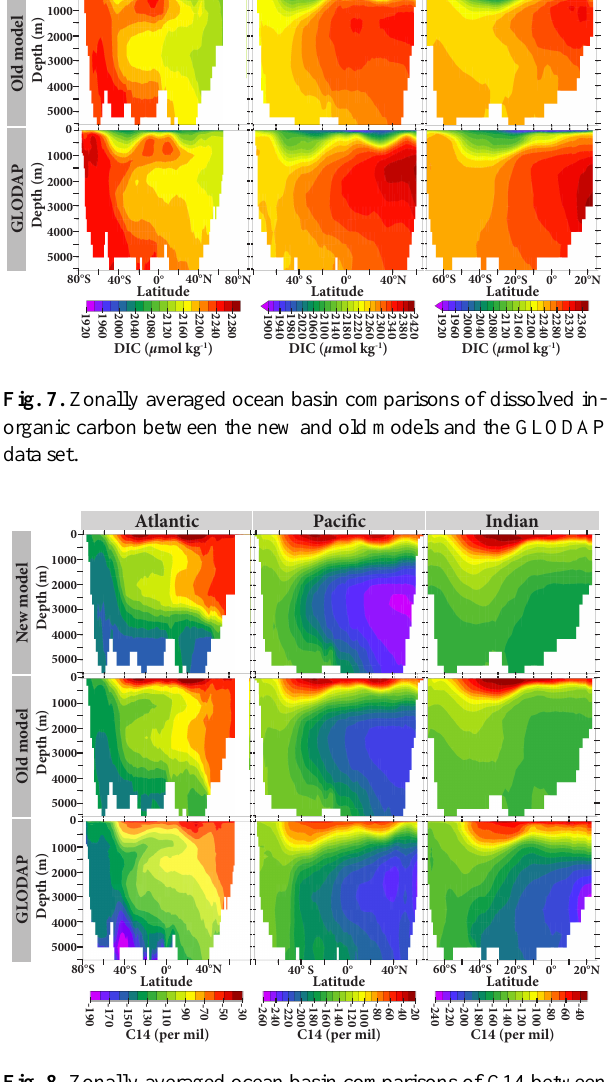
( ± 20) Tg N yr − 1 suggested by Gruber and Sarmiento (2002) and Gruber (2004). As with other model results, the loca- tion of water column denitrification with the new model is somewhat different than with the old model (Fig. 16). The new model simulates distinct areas of denitrification in the Eastern tropical North and South Pacific with the most in- tense denitrification occurring in the grid boxes bounded by land (Fig. 16a). While with the old model denitrification in the Eastern tropical North and South Pacific occurred